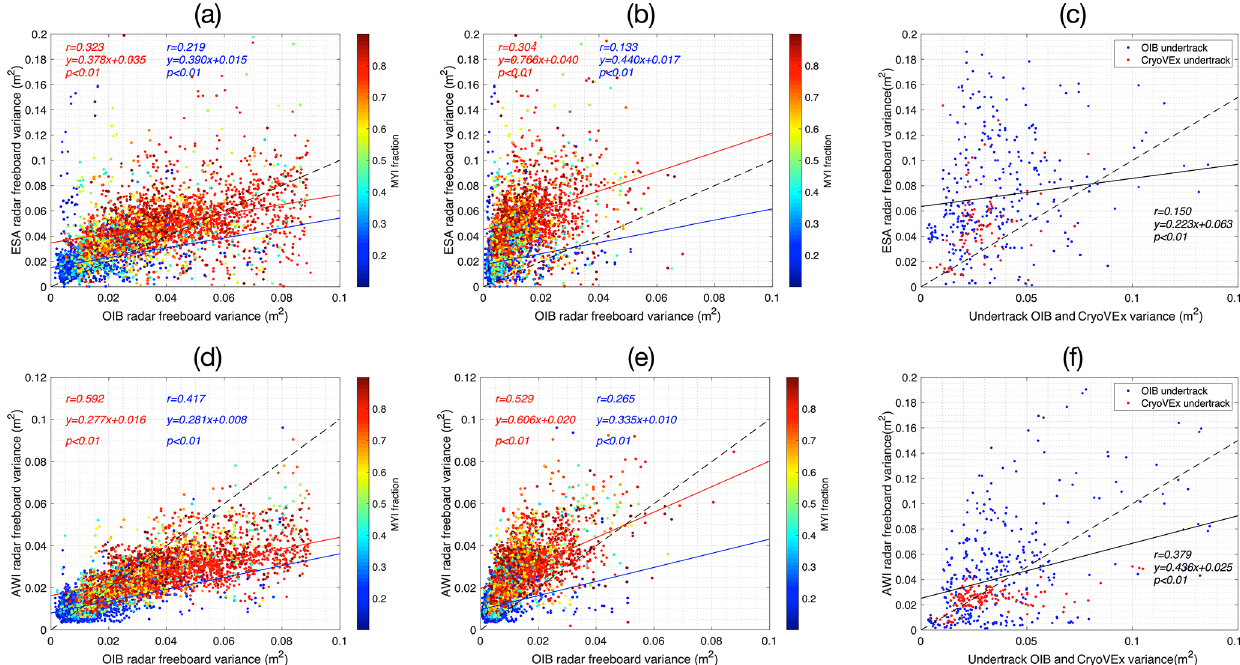
Figure 4. Sample variance in F r between OIB, CryoVEx and CS-2. Panels (a, b, c) compare ESA F r with OIB and CryoVEx, while (d, e, f) use AWI F r product for the comparison. Panels (a) and (d) use the sample variances as measured by original OIB resolution (40m), while panels (b) and (e) use those of OIB on 400m resolution (local averaging with M = 10). Panels (c) and (f) show the comparison of the collocating tracks of OIB and CryoVEx with CS-2 on the scale of CS-2’s along-track footprint of 400m.